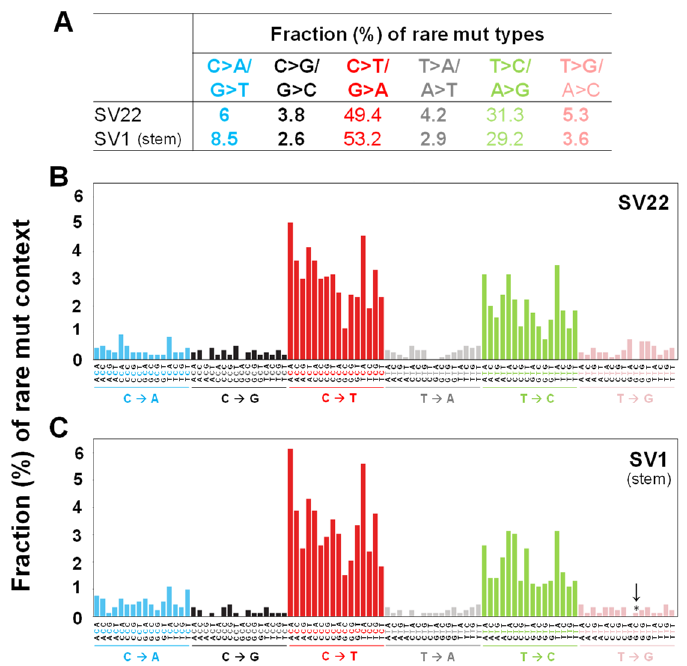
Figure 2. Types and sequence context spectra of rare unique mutations in the whole mtDNA.